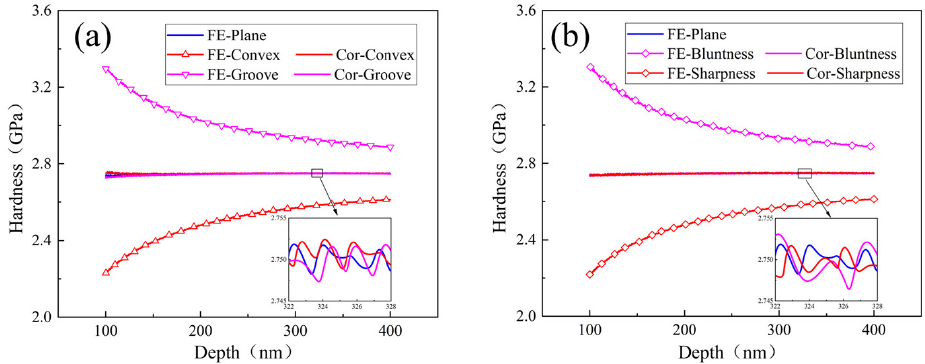
Figure 18. Numerical correction of measured hardness. FE—finite element simulation, Cor—correction. The inaccurate hardness is corrected to true hardness through compensating defect height: ( a ) surface defect; ( b ) indenter tip irregularity.